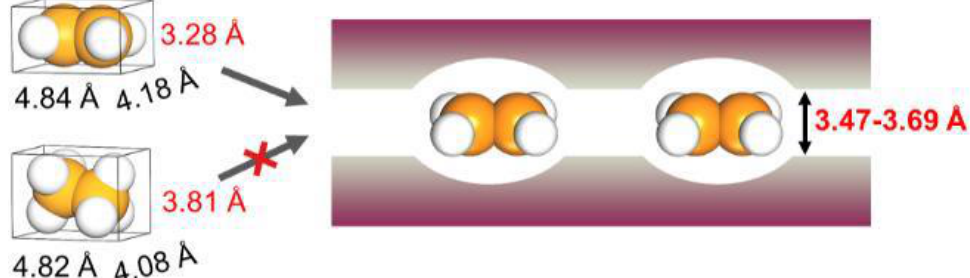
Figure 3. Schematic diagram of molecular sieving of ethylene and ethane. Reprinted with permission [35].